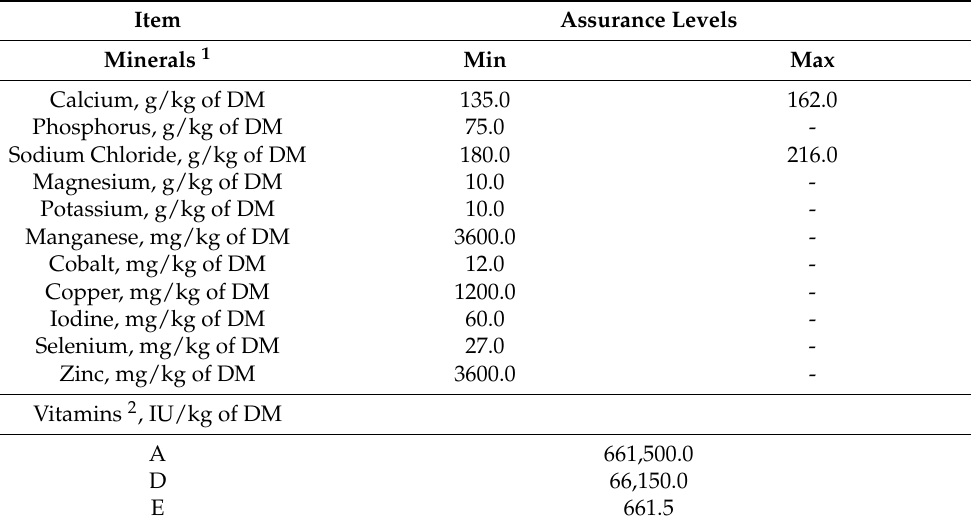
Table 1. Micronutrient composition of vitamin and mineral (VTM) supplement 1 provided to beef heifers during the first trimester of gestation; company guaranteed analysis.